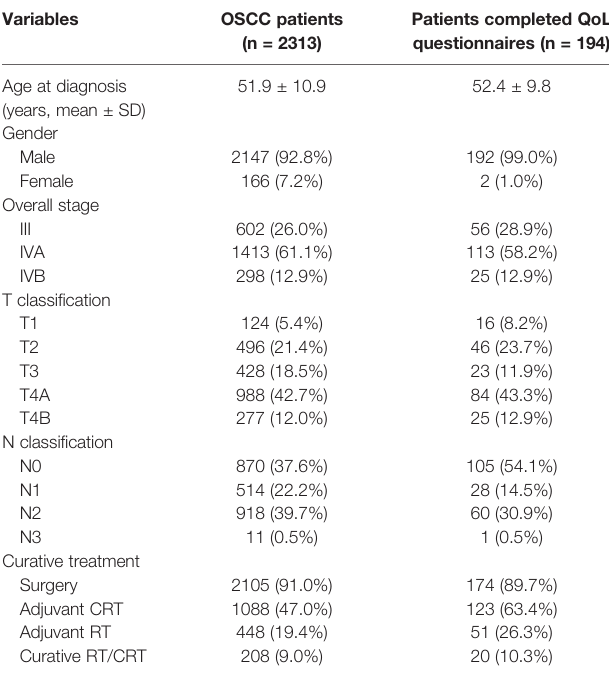
TABLE 1 | Baseline patient